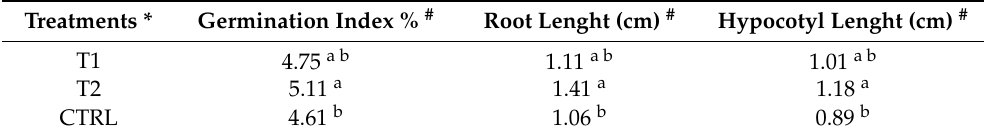
Table 4. Effect of S. violaceoruber culture seed-priming treatment on the germination index (%) and root and hypocotyl length of tomato